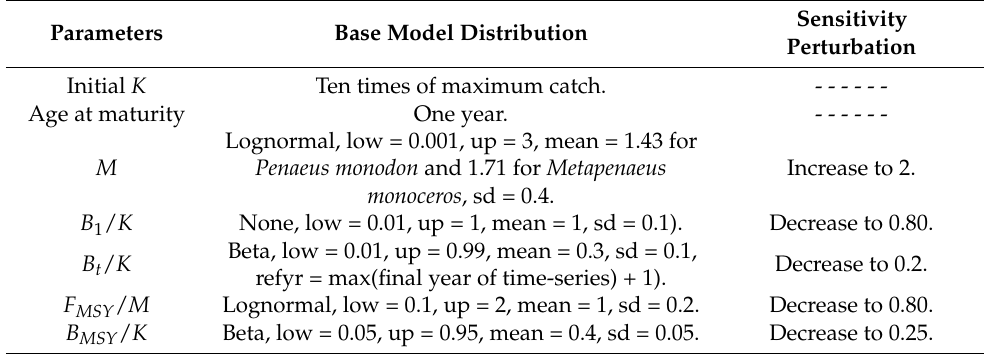
Table 1. Input distribution for the DB-SRA analysis base model and sensitivity